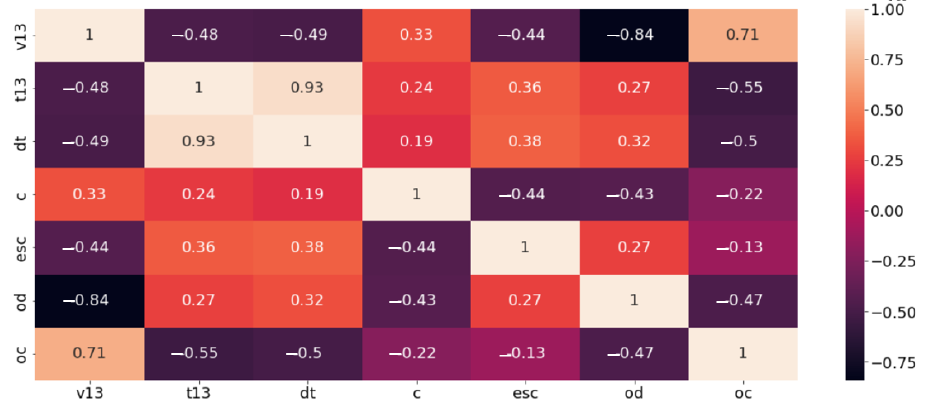
Figure 6. Pearson’s graphicwith the relation between the variables. The closer to 1, the stronger the relationship between the variables. On the other side, the closer to − 1, the stronger the negative relationship. A score closer to zero should be ignored by the